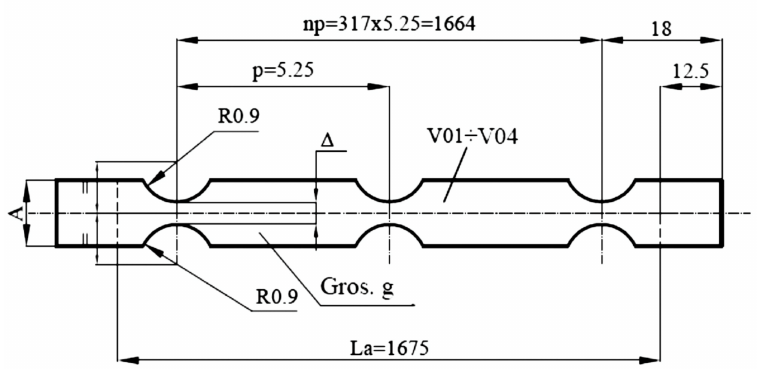
Figure 3. Drawing of the fuse element used in